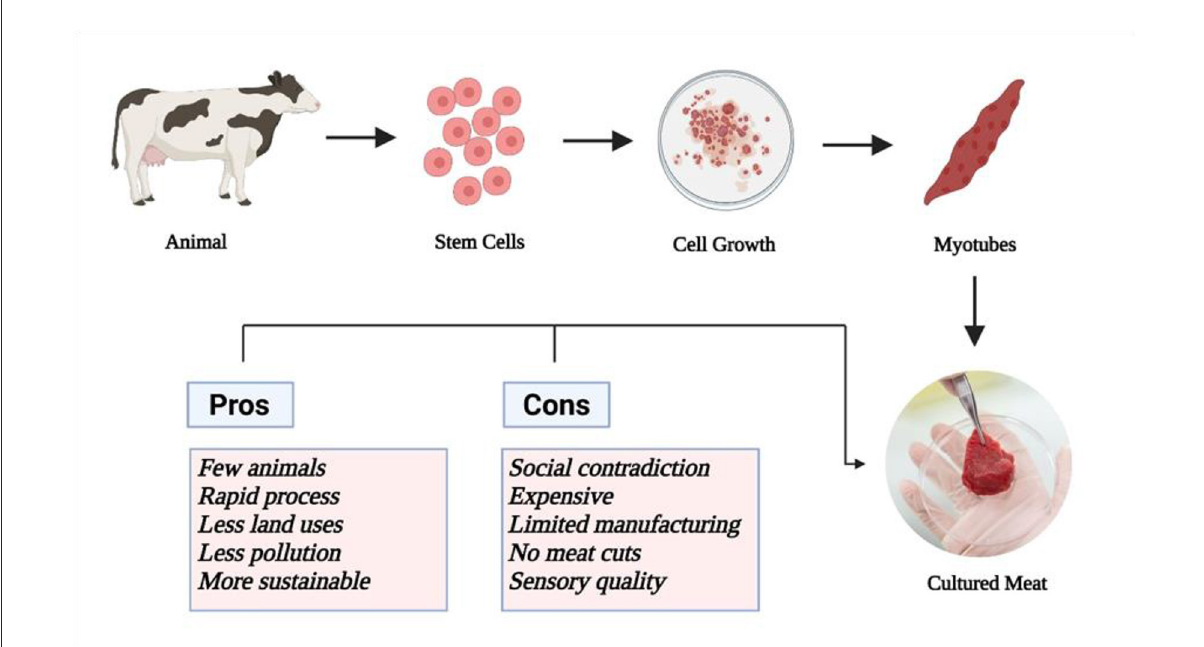
FIGURE3 Process for the production of cellular meat with its pros and